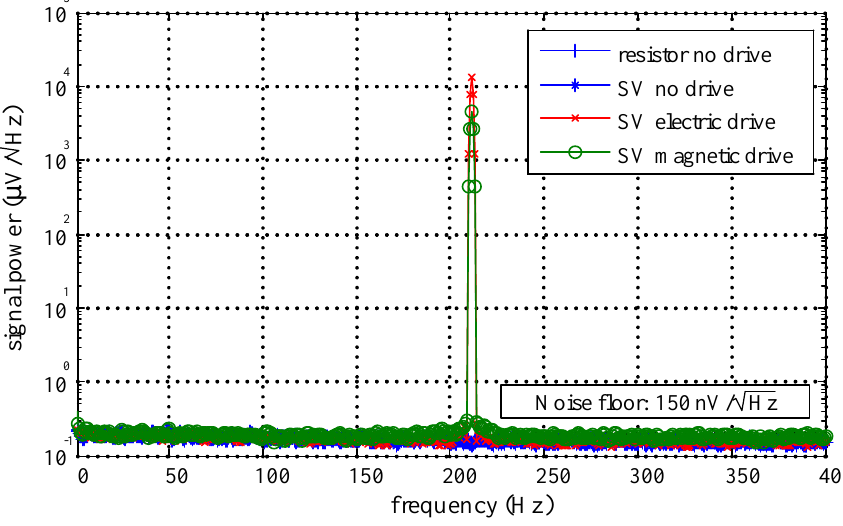
Figure 9. Power spectrum of the acquired signals for different loads and driving